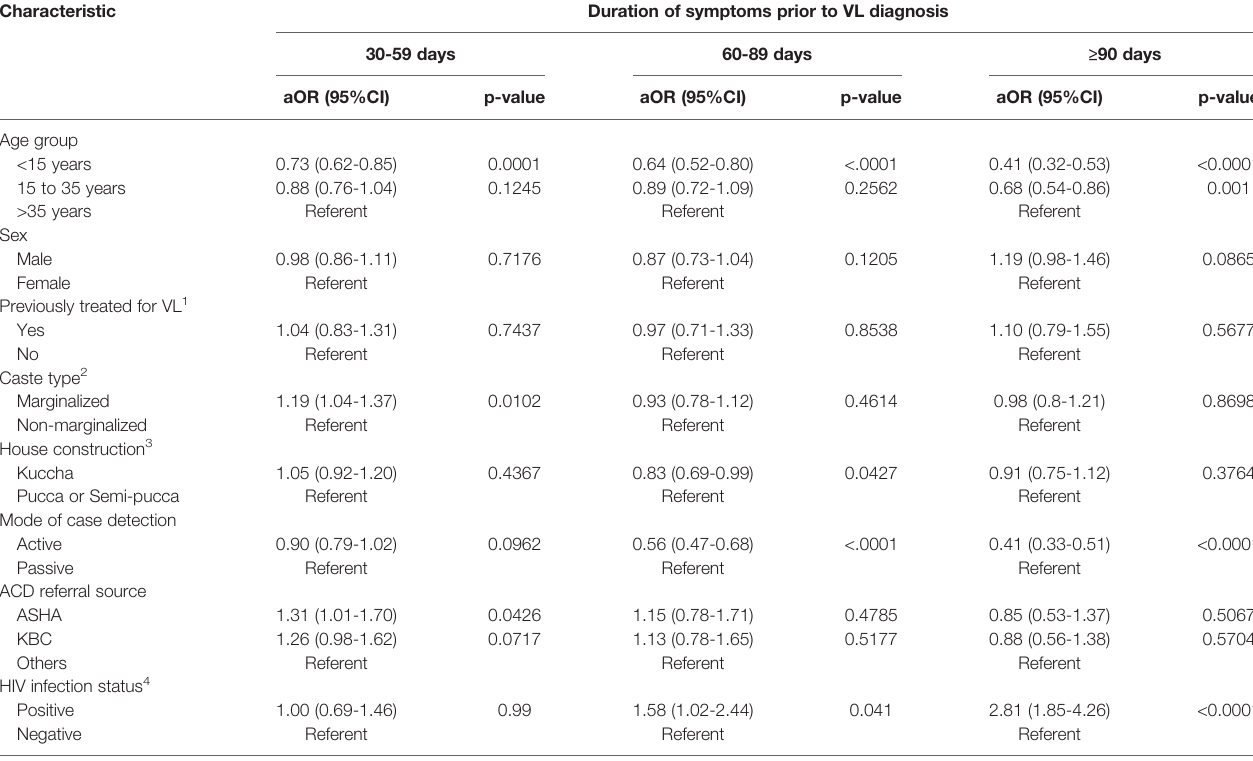
Intervals of 30-59, 60-89 and ≥ 90 days are compared to <30 days. 1 Data missing for 3 patients. 2 Data missing for 12 patients. 3 Data missing for 7 patients.